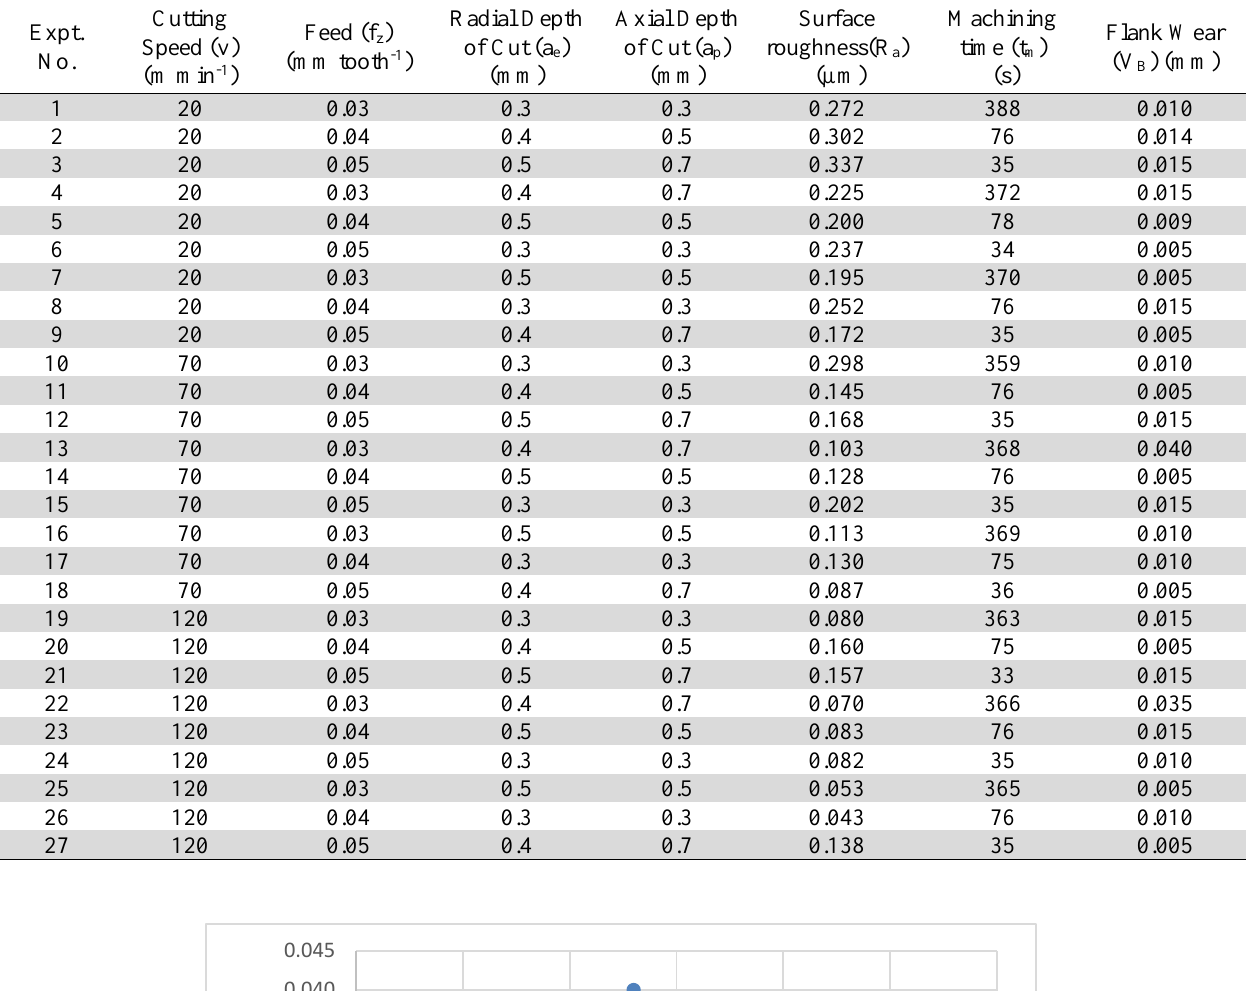
Table 2 Dataset for measured values of the responses Expt.